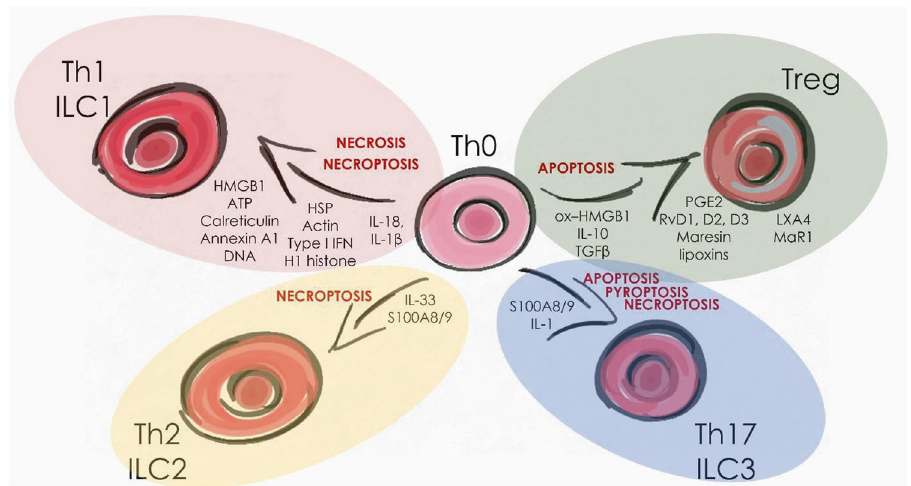
Fig. 3 DAMP and SAMP molecules regulating Th cell differentiation. Types of cell death, DAMP and SAMP molecules directly associated with T helper cell subpopulations based on literature data. HMGB1 High mobility group box 1, PGE2 Prostaglandin E 2 , TGF β Transforming growth